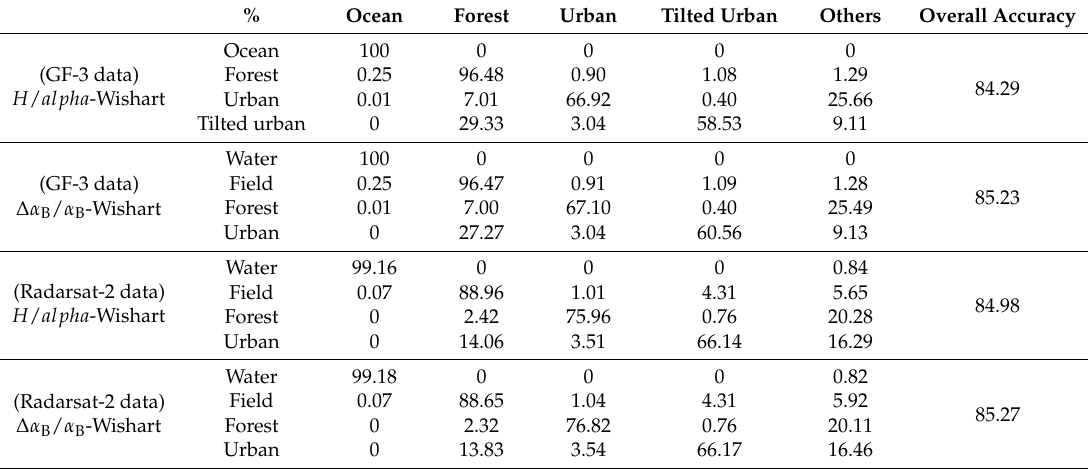
Table 3. Comparison of the GF-3 and the Radarsat-2 data classification results by using the Wishart